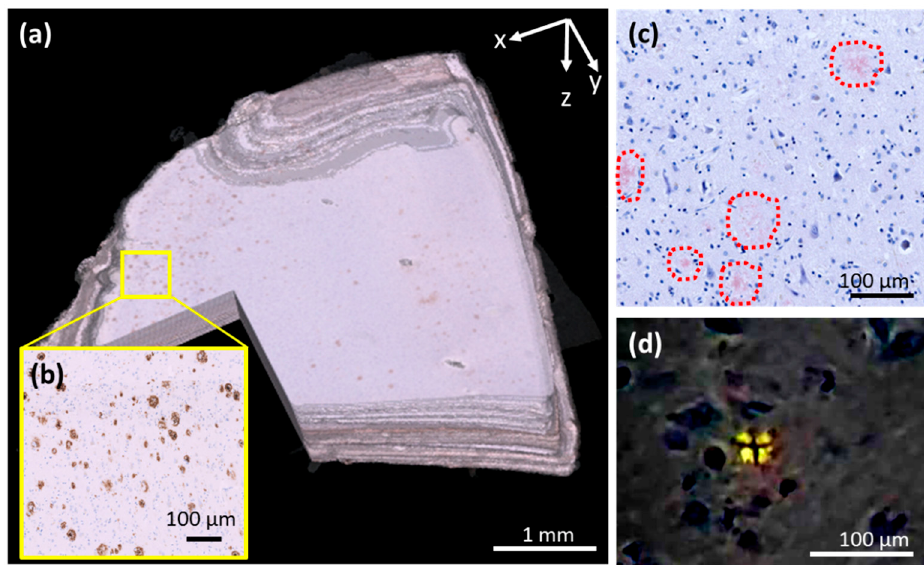
Figure 6. Histological analysis of Alzheimer’s disease (AD) human brain samples. ( a ) Three-dimensional reconstruction and rendering of 180 immunohistochemically stained serial sections. ( b ) Zoom-in into a plaque-rich cortical region where brown staining indicates amyloid-beta deposits. ( c ) Congo red stained section imaged by bright-field microscopy. Plaques appear as reddish accumulations. Red circles indicate neuritic plaques. ( d ) Congo red staining investigated by polarized light microscopy. A neuritic plaque can be observed in characteristic apple-green color and cross- shaped form.